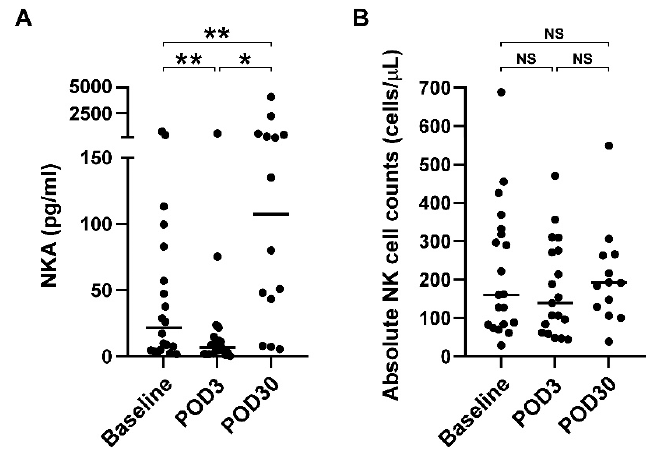
Figure 1. Impaired NKA recovered after surgical resection of glioblastoma on POD30. ( A ) NKA was measured before (baseline) and after surgical resection of glioblastoma on POD3 and POD30. NKA was determined by measuring the NK-released IFN- γ using the NK VUE kit. Data were presented as scatter plot, and differences between groups were statistically analyzed using the two-tailed Wilcoxon matched-pairs signed-rank test. Differences were found to be statistically significant at * p < 0.05 and ** p < 0.01. Solid line indicates the median. ( B ) Absolute NK cell counts were determined from patients before and after surgical resection of glioblastoma. Data were presented as scatter plot and median, and differences between groups were statistically analyzed using the two-tailed Wilcoxon matched-pairs signed-rank test. NS denotes no statistically significant difference. Abbreviation: NKA, natural killer cell activity; POD3, postoperative day 3; POD30, postoperative day 30.